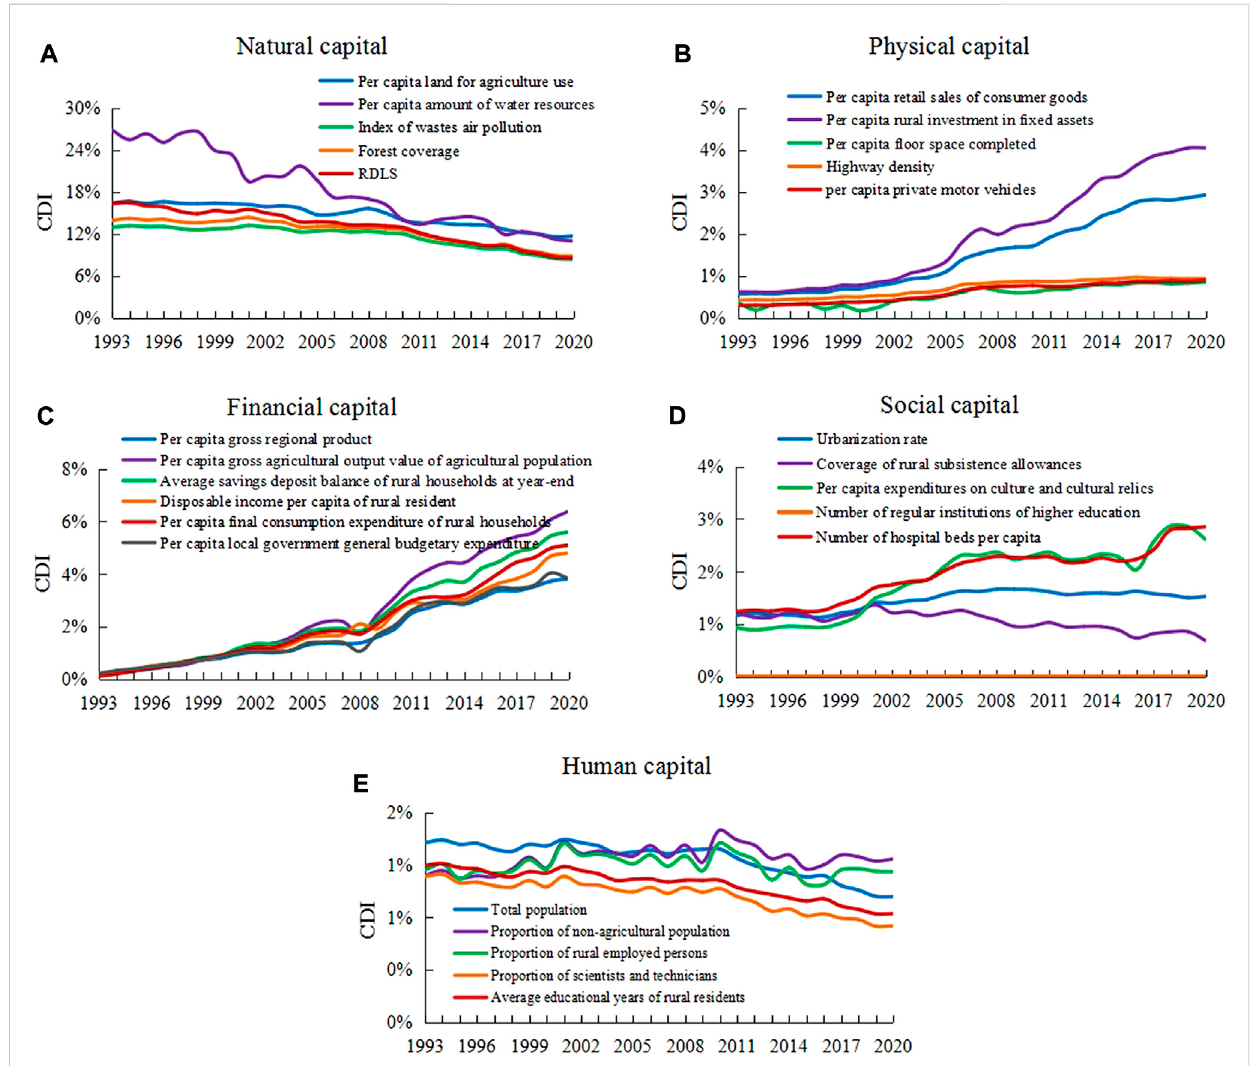
FIGURE 6 Development of CDI in Diqing (1993 – 2020). (A) Natural capital. (B) Physical capital. (C) Financial capital. (D) Social capital. (E) Human